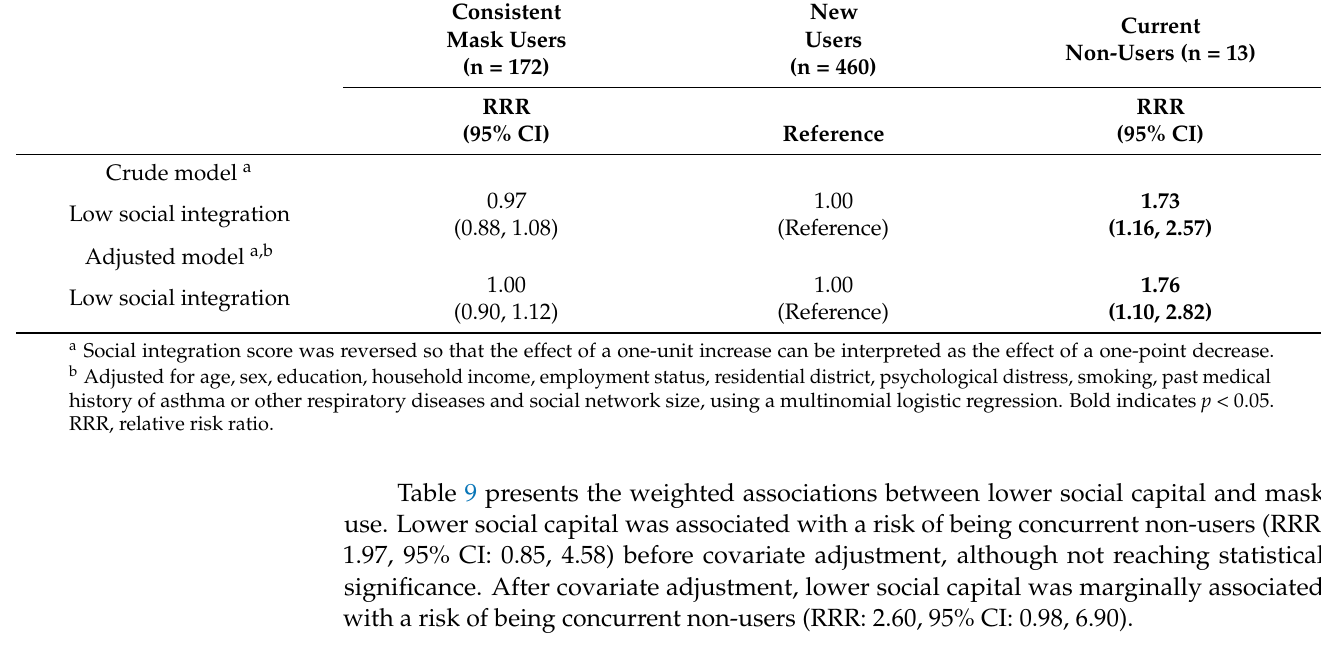
Table 9. Weighted associations between lower social capital and mask use behavior in imputed dataset (n =